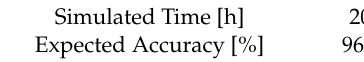
Table 12. BESS models' average error in estimating SOC during a market session of the automatic frequency restoration reserve (aFRR) provision.